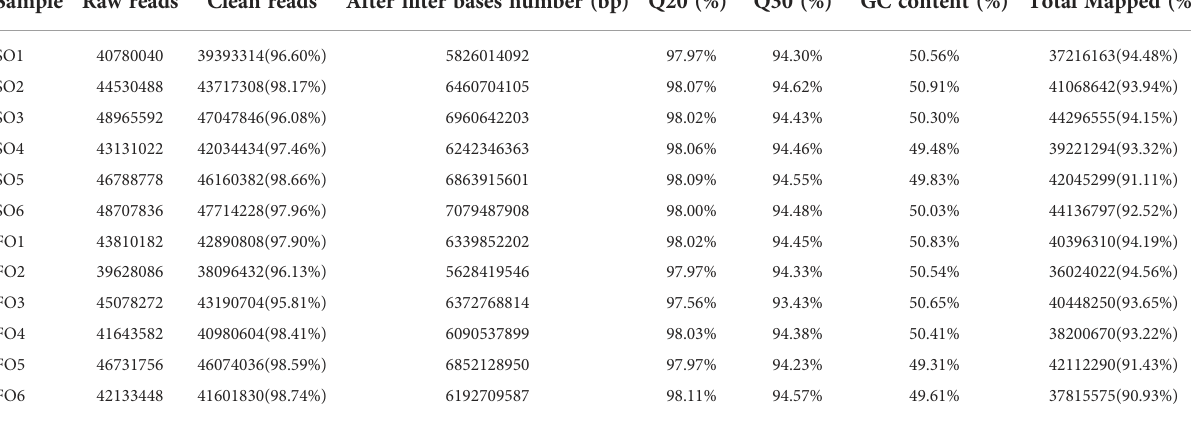
TABLE 3 Summary of the sequencing data in the ovary of the adult spotted scat fed with different types of oil